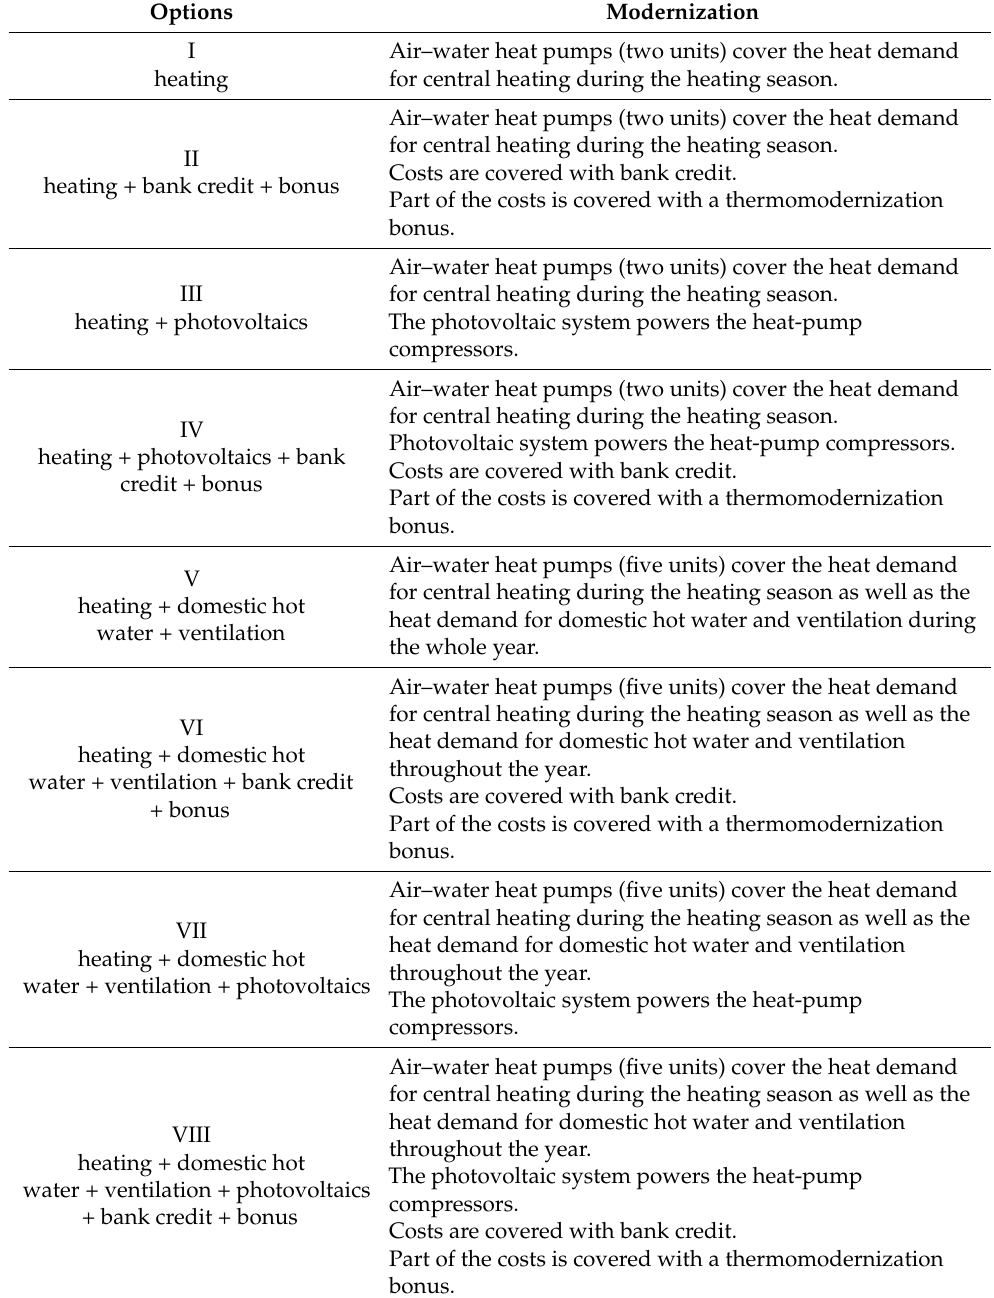
Table 2. Researched solutions for a hybrid district-heating